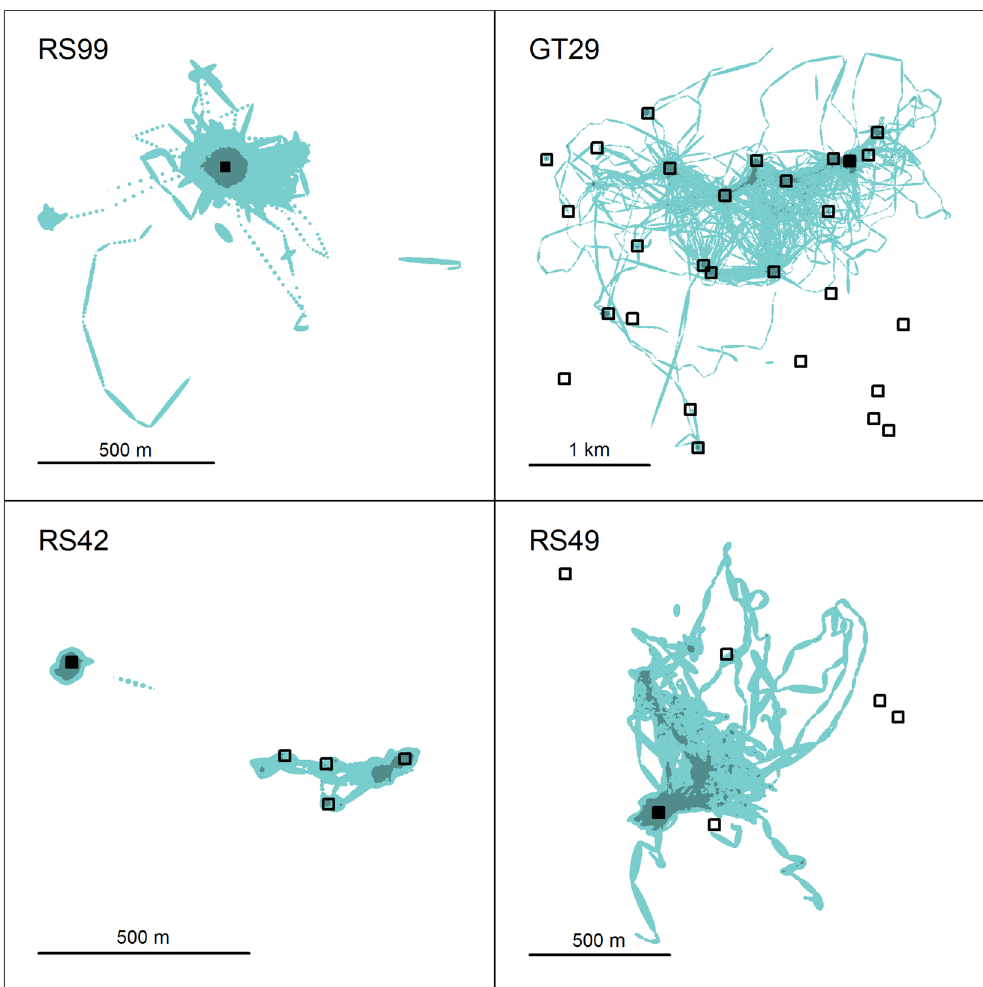
Figure 3. Brownian Bridge modeled area used by 4 tagged fish over the duration of the study: red snapper RS99, tracked 236 days in the 55-m array; gray triggerfish GT29, tracked 266 days in the 30-m array; red snapper RS42, tracked 144 days in the 30-m array; and red snapper RS49, tracked 123 days in the 30-m array. Artificial reefs are marked with square symbols, while the reef where each fish was tagged and released is filled. For each figure, darker shading represents the home range (95% KDE) and lighter shading represents all modeled area used over the entire study